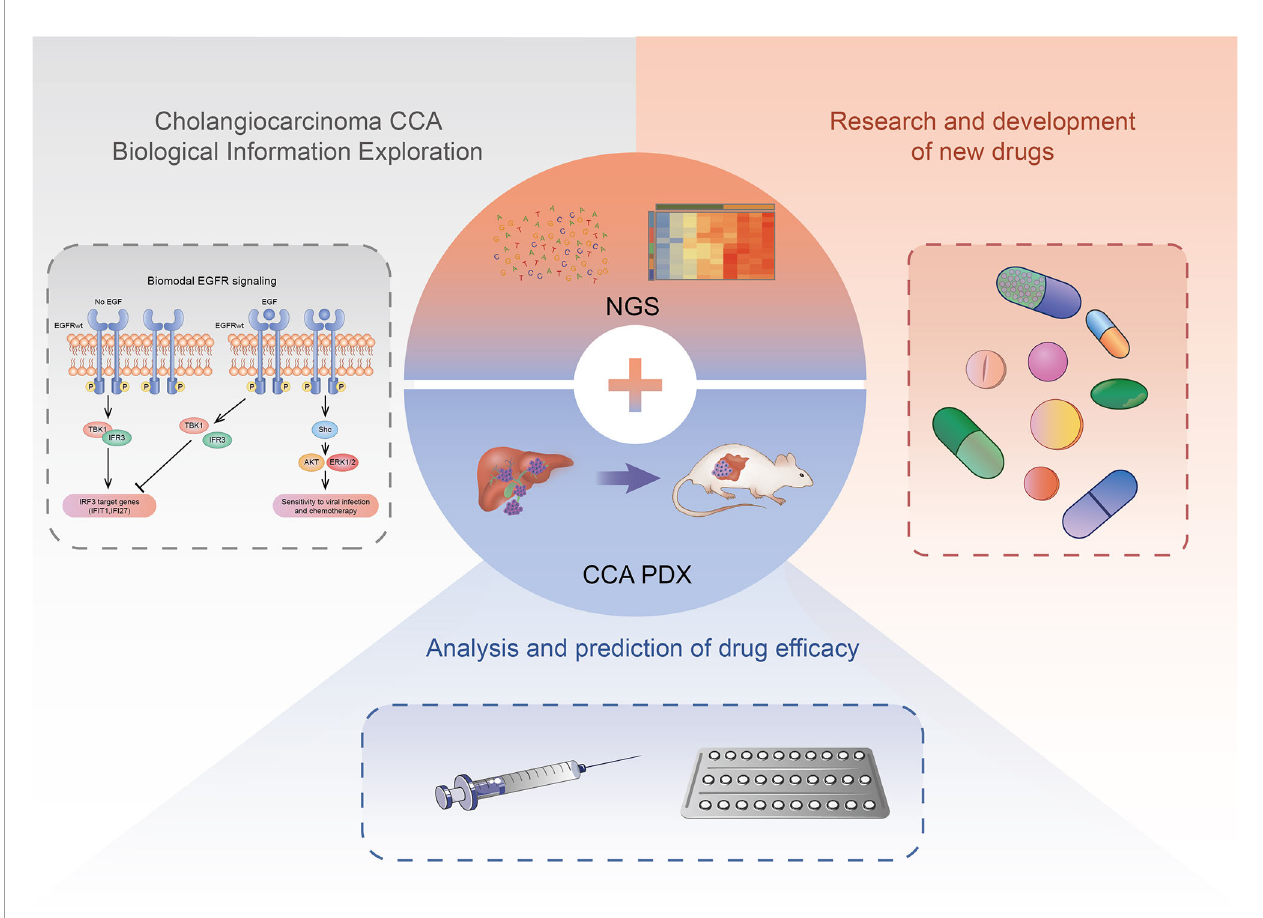
FIGURE 2 | The application of CCA PDX models. The CCA PDX models have application potential in basic research, new drug development, and ef fi cacy evaluation of the antineoplastic